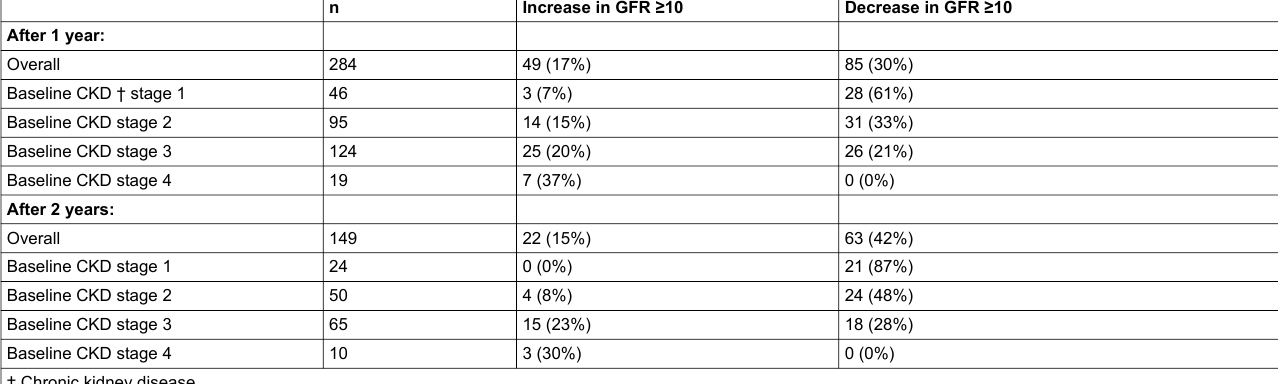
Table 3 : Changes in glomerular filtration rate according to baseline CKD stage after 1 and 2 years.